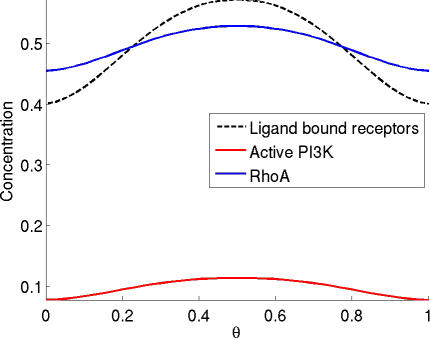
Effect of F-Actin Inhibitor on Signal PolarizationSteady-state distribution of receptor–chemoattractant complexes (black), activated PI3K (red), and RhoA(blue). The simulations were performed using a 100% gradient (bL = 1 and gL = 100%). Weaker gradients yielded a flatter response as the inhibition of actin decreases the sensitivity of the response.